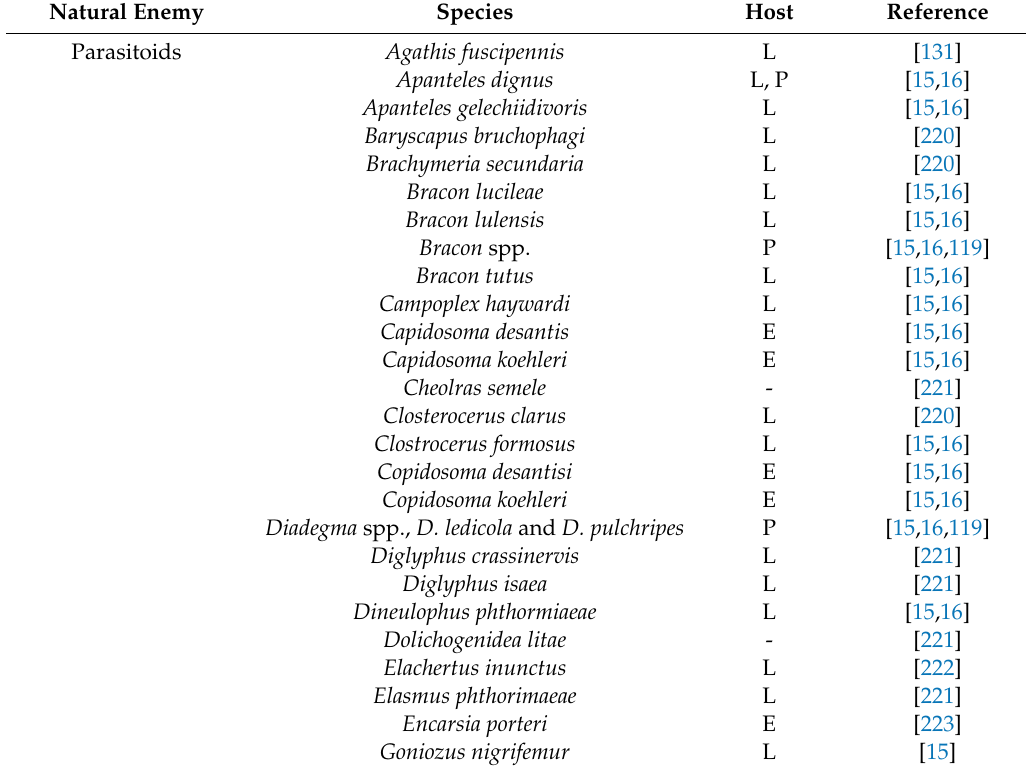
Table 4. Natural enemies (parasitoids and predators) reported in literature for Tuta absoluta. The list may not be purely exhaustive but was compiled using the available literature at the time of